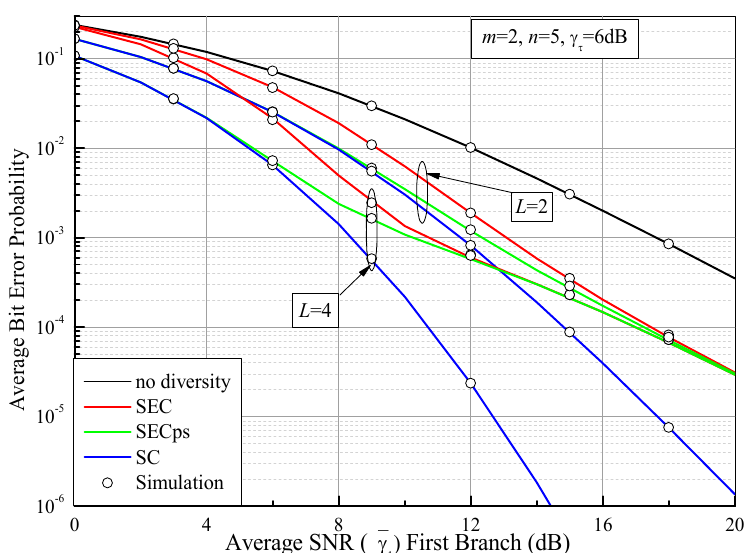
Figure 7. ABEP vaules of DPSK for the SEC and the SECps as a function of the average SNR of the first branch ( γ 1 ) over i.i.d. Fisher–Snedecor F fading channels with m = 2, n = 5, and γ τ = 6 dB.